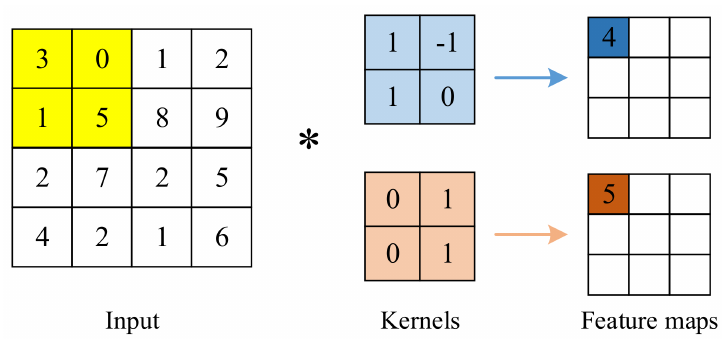
Figure 1. Convolution